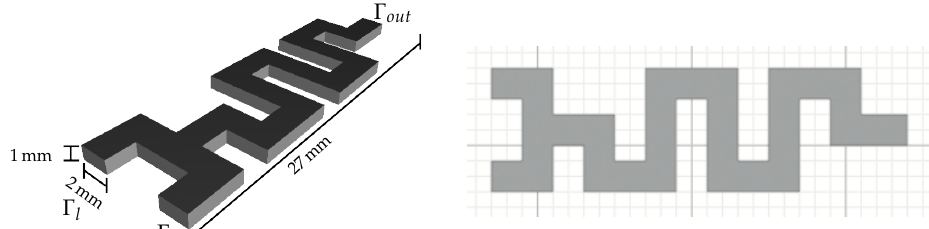
Γ out . ( Right ): Dimensions of the channel in the